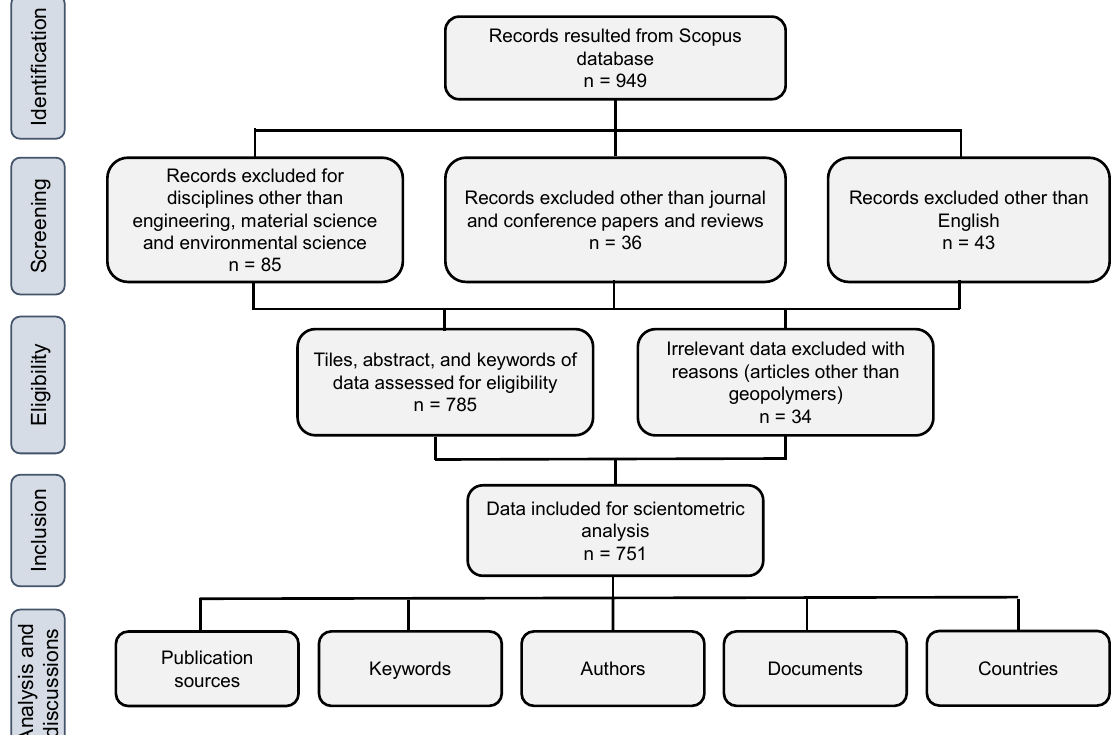
Figure 1. Flowchart of PRISMA technique for data retrieval, filters applied, and analysis.